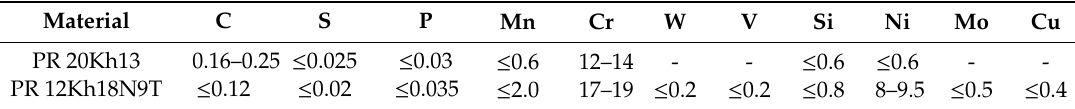
Table 1. Chemical composition of the chosen steel powder grades, %.